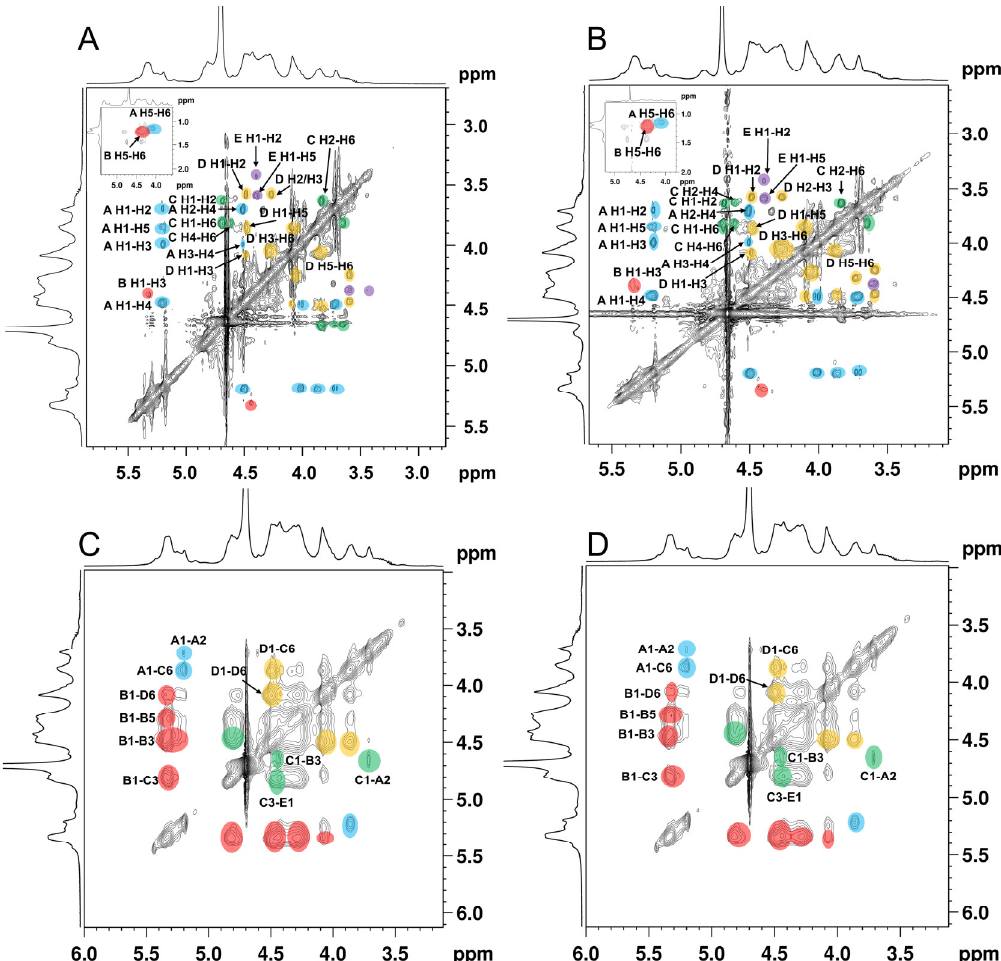
Figure 4. TOCSY spectra of ANP-6 ( A ) and ANP-7 ( B ) and NOESY spectra of ANP-6 ( C ) and ANP-7 ( D ).